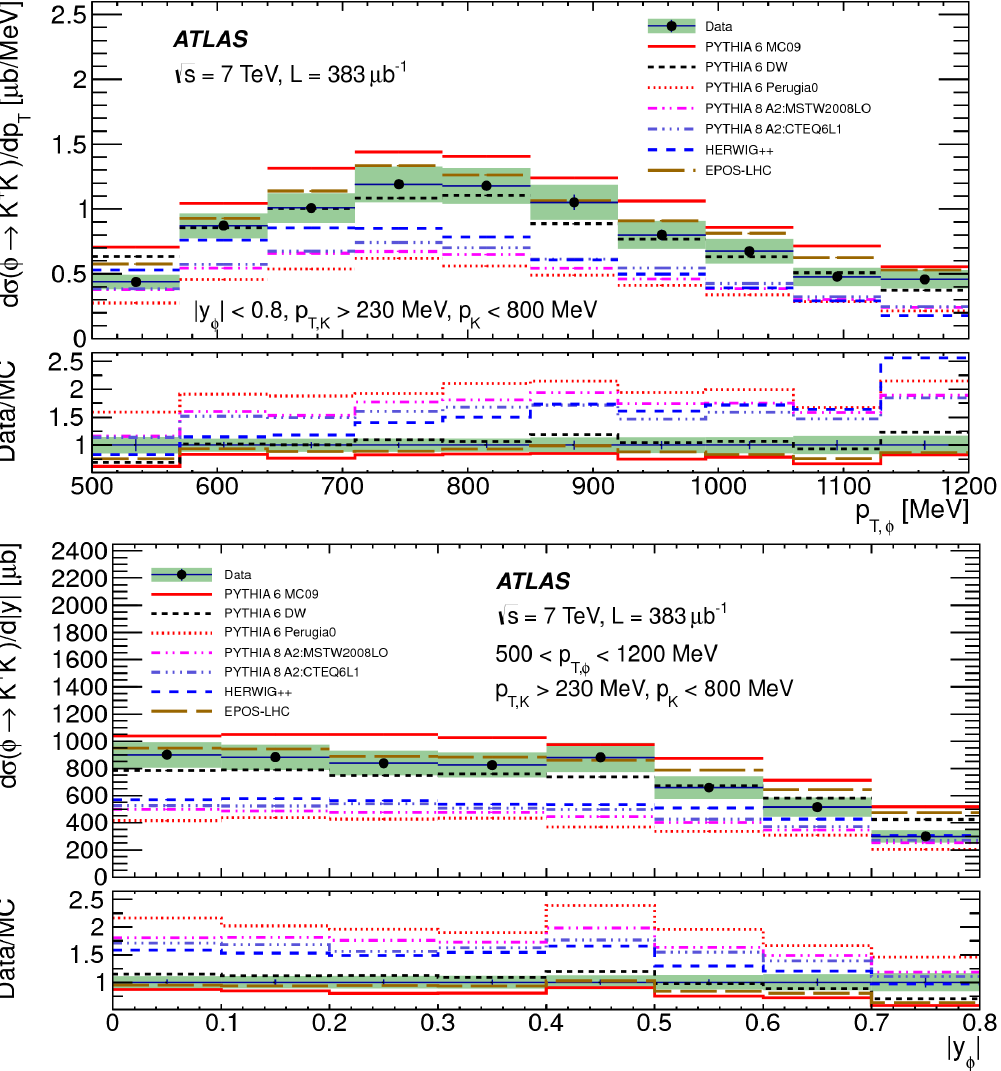
Figure 1: The φ (1020) → K + K − cross section as a function of p T ( φ ) (left) and | y ( φ ) | (right), in the fiducial region of 500 < p T ( φ ) < 1200 MeV and | y ( φ ) | < 0.8.